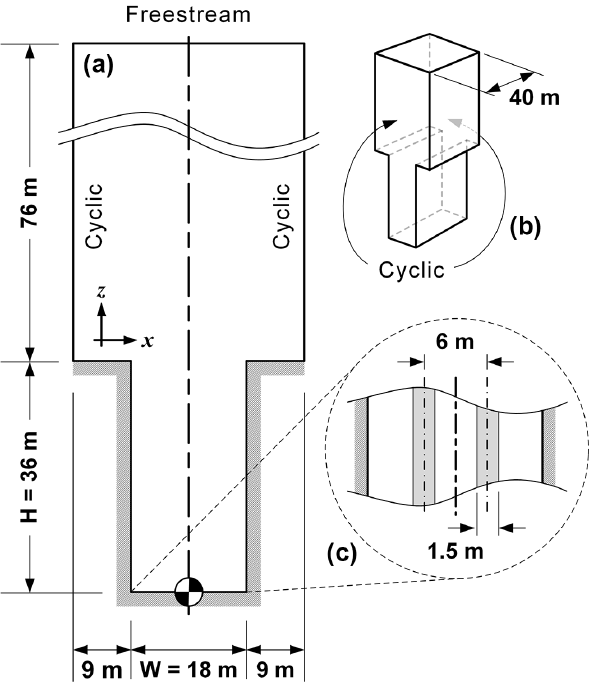
Figure 1. Schematic of the solution domain representing the infinite street canyon geometry from Zhong et al. (2015): (a) basic dimensions and locations of cyclic and freestream boundaries, (b) isometric view of the domain showing lateral dimension and corresponding cyclic boundaries, and (c) top view of ground surface indicating size and position of simulated traffic